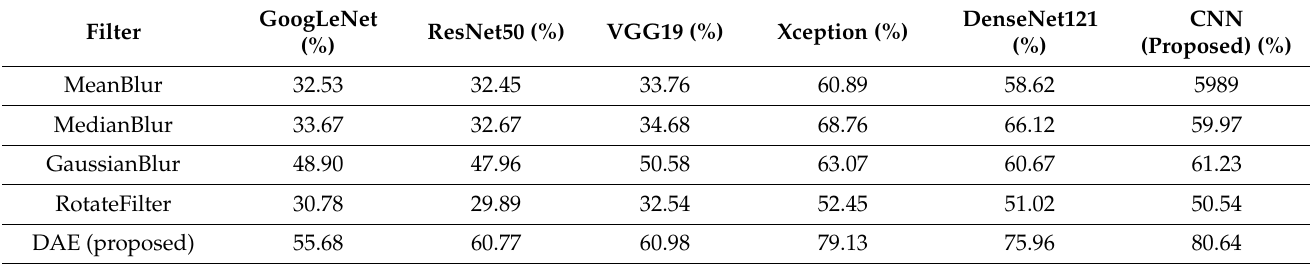
Figure 18. Comparison results of the testing accuracies obtained by the defensive models based on the MI-FGSM text-based CAPTCHA attack. Table 6. Comparison accuracy results, defending against the I-FGSM attack, using image processing filters with the transfer learning models compared to the proposed DAE-CNN model based on the testing dataset.